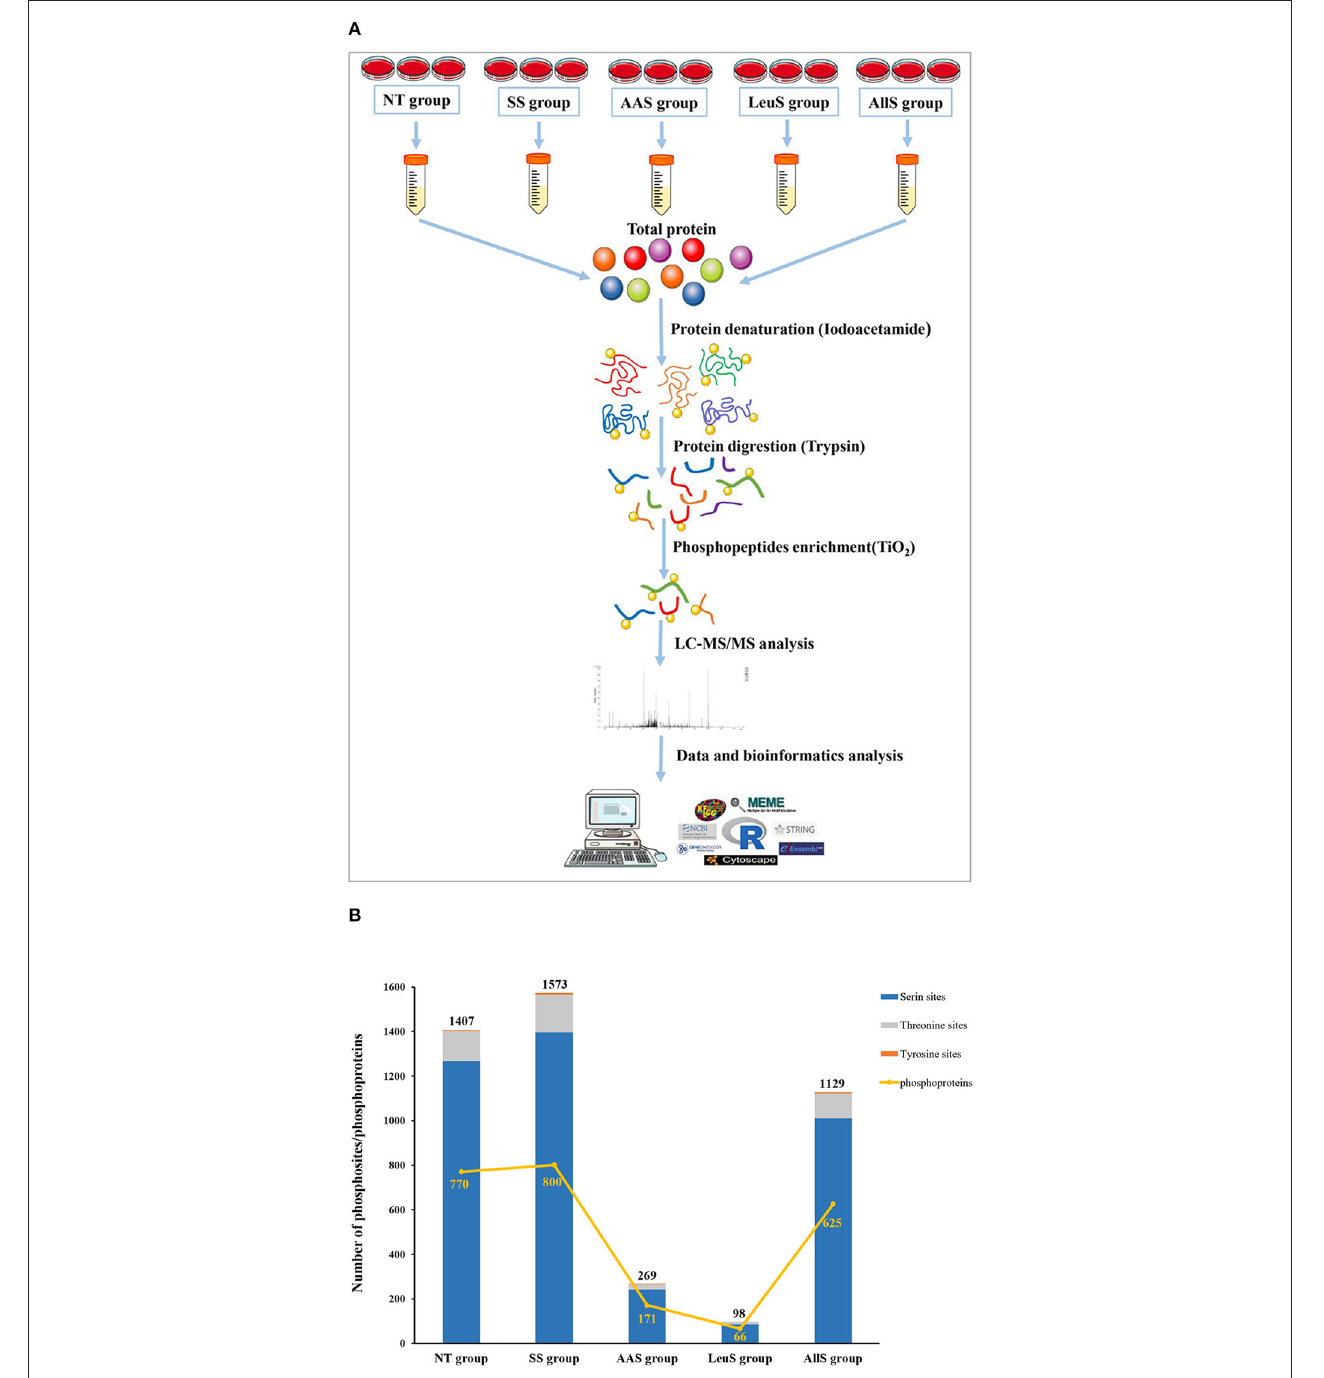
FIGURE 3 | Procedures and basic identification information for the phosphoproteomics analysis. (A) Abridged general view of the phosphoproteomics analysis. The proteins were extracted from cells in non-treated condition (NT group), serum starvation medium for 16h (SS group), amino acid starvation medium for 1h after serum starvation (AAS group), 450 µ M leucine restimulation medium for 1h after serum and amino acid starvation (LeuS), and all amino acid restimulation medium for 1h after serum and amino acid starvation (AllS group). Then, proteins were subjected to reductive alkylation treatment using iodoacetamide, followed by digestion into short peptides using trypsin. Subsequently, phosphatides were enriched using TiO 2 and detected by LC-MS/MS. Proteins were identified by ProteinPilot software, and bioinformatics analyses were performed using R software, Cytoscape software, and MoMo software. (B) The numbers of phosphosites in the NT, SS, AAS, LeuS, and AllS groups were 1,407, 1,573, 269, 98, and 1,129, respectively. The numbers of phosphoproteins identified in the NT, SS, AAS, LeuS, and AllS groups were 770, 800, 171, 66, and 625, respectively.